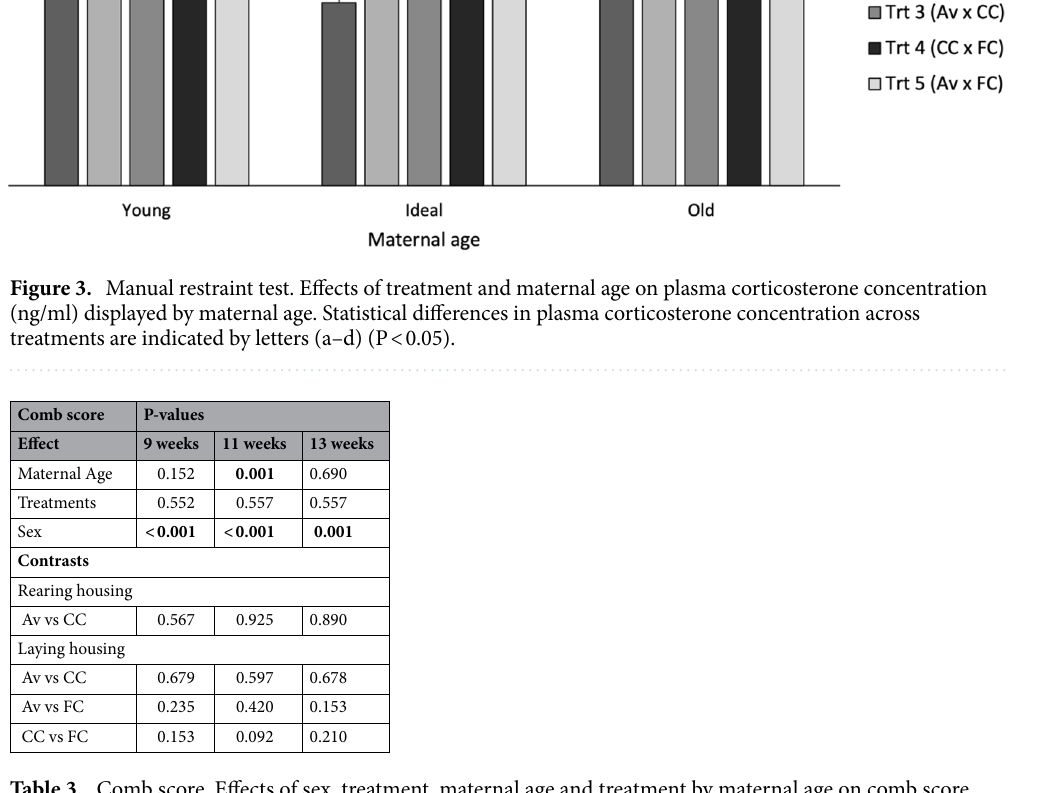
Table 3. Comb score. Effects of sex, treatment, maternal age and treatment by maternal age on comb score, and contrast comparisons by rearing and laying environments. Data are summarized in the text and presented in Supplementary Table S1). P-values less than 0.05 are